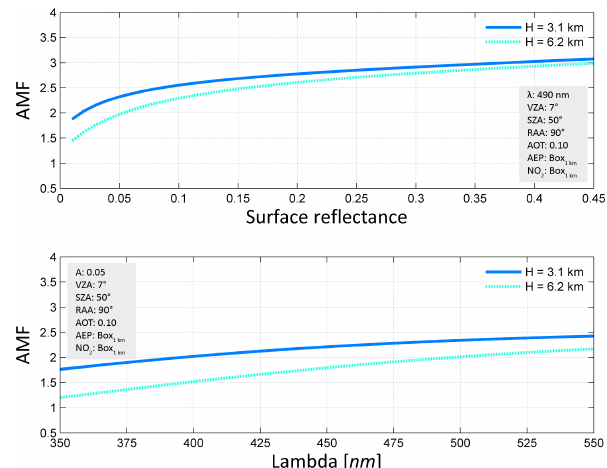
Figure 10. Dependence of the AMF on the surface reflectance and RTM computation wavelength ( λ ) for the aircraft altitude of the Cessna 207T D-EAFU ( H = 3 . 1kma.g.l.) and the Dornier DO- 228 D-CFFU ( H = 6 .